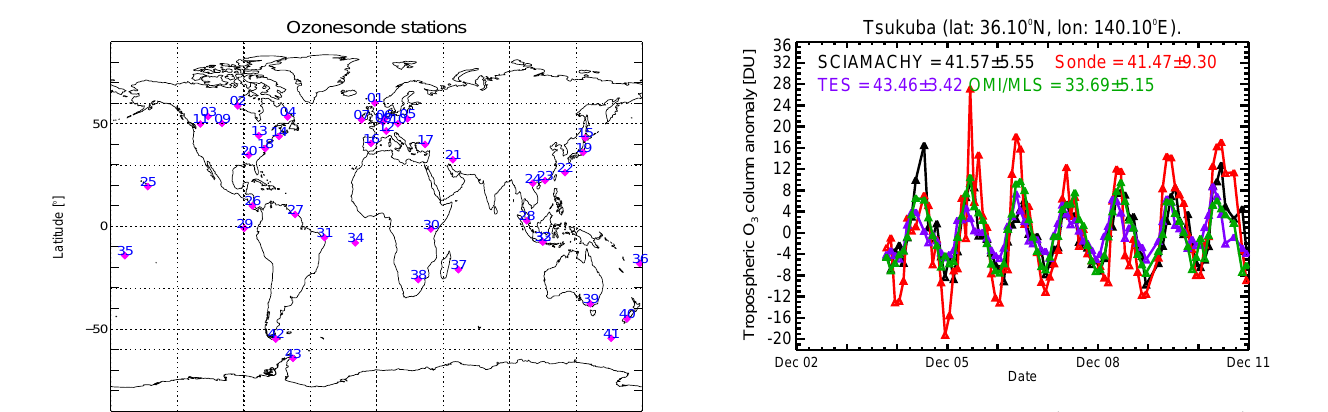
Figure 7. As Fig. 6, but over Tsukuba (36.10 ◦ N, 140.10 ◦ E). Hilo (lat: 19.43 0 N, lon: 155.04 0 W).